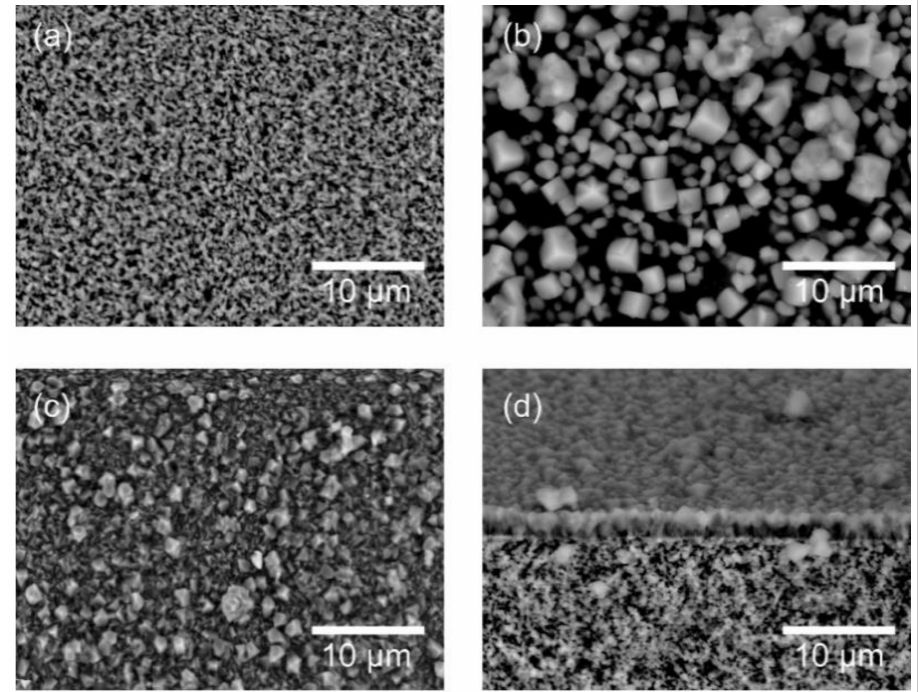
Figure 2. SEM images of ( a ) porous support tube, ( b ) seed particles, and ( c ) top surface and ( d ) frac- tured section of the